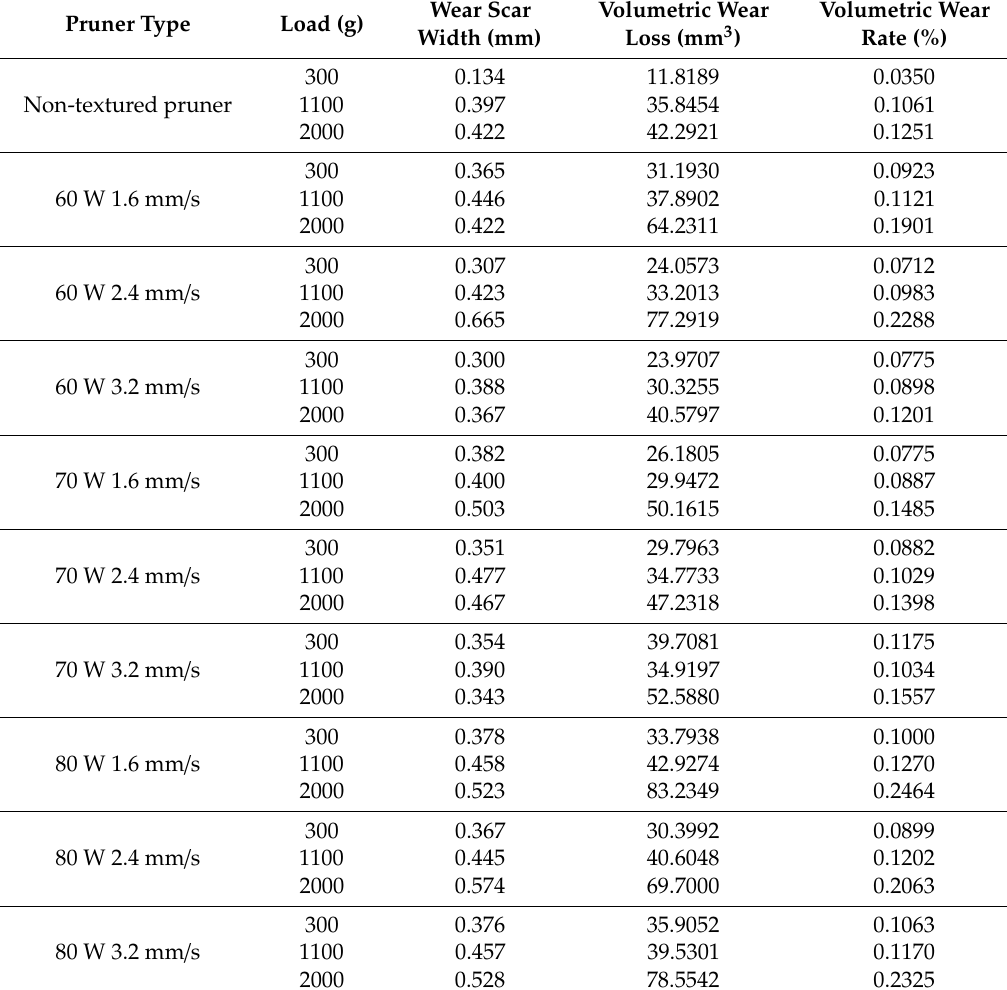
Table 8. Wear test